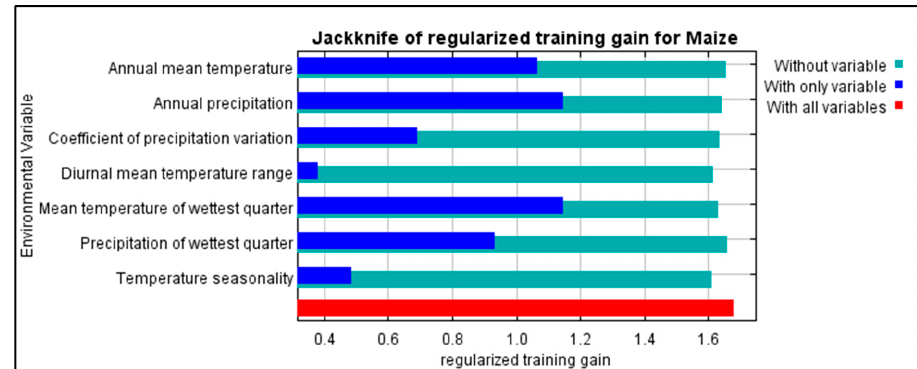
Figure 4. Results of jackknife test showing potential climatic contributors to suitability for maize cultivation. Regularised-training gain defines how well the model distribution fits the presence data compared to a uniform distribution. The light blue bars (without variable ) show the gain lost when the variable is removed from the model, while the dark blue bars (with only one variable) indicate the gain from using a variable in isolation, and the red bar (with all variables) indicates the gain in using all variables in the